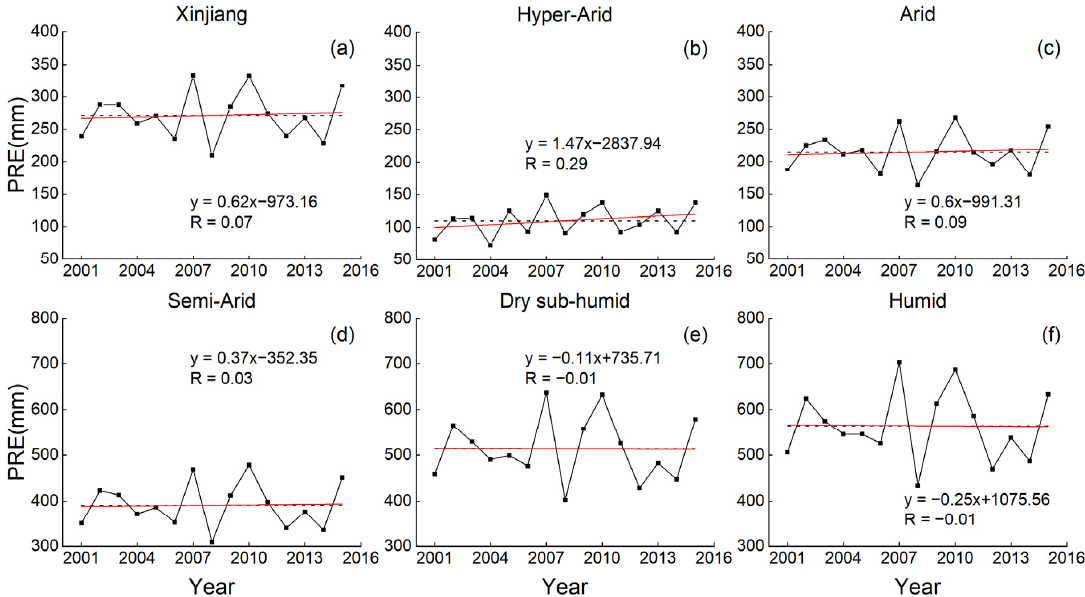
Figure 9. Inter-annual variations in PRE in different climate zones from 2001 to 2015 are shown for ( a ) the entire Xinjiang region, ( b ) hyper-arid region, ( c ) arid region, ( d ) semi-arid region, ( e ) dry sub- humid region, and ( f ) humid